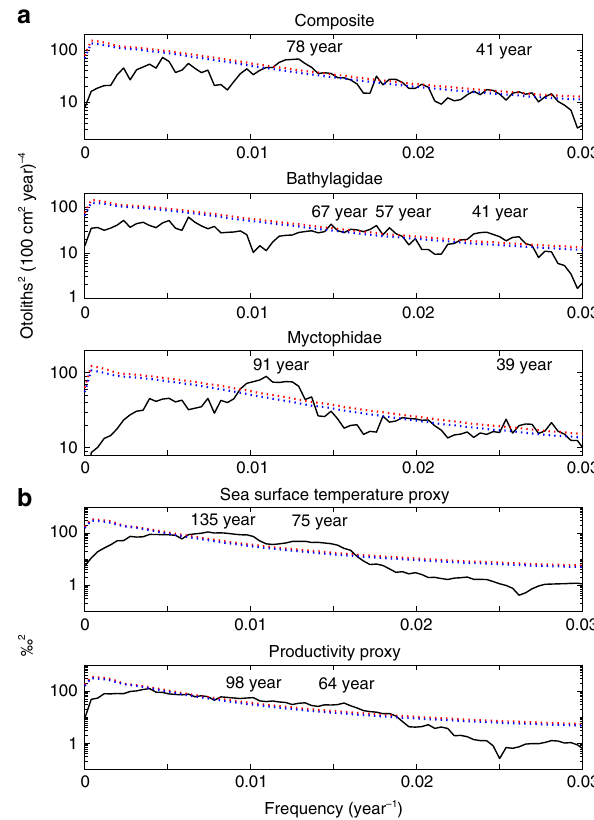
Fig. 4 Global power spectra for otolith deposition rate and environmental proxies. a Global power spectra for otolith deposition rate of Composite (all classi fi ed otoliths, n otoliths = 1188), Bathylagidae ( n otoliths = 367), and Myctophidae ( n otoliths = 413). b Global power spectra for proxies of sea surface temperature and primary productivity (10-year bins, n bins = 188). Filtered to remove periods less than 30 years and greater than 500 years. Dotted lines are con fi dence limits (red, 95%; blue, 90%; two-sided) computed assuming a red-noise background with fi rst-order autocorrelation. Periods of major peaks exceeding 95% are labeled. See Methods section for details. Source data are provided as a Source Data fi